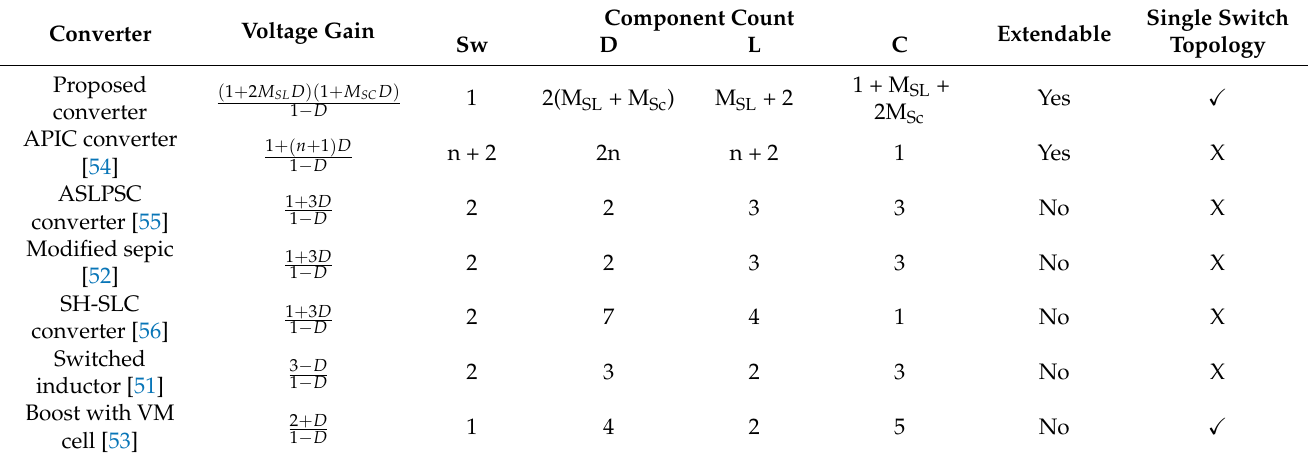
Table 5. Comparison of PSLSC converter and existing high gain converters.